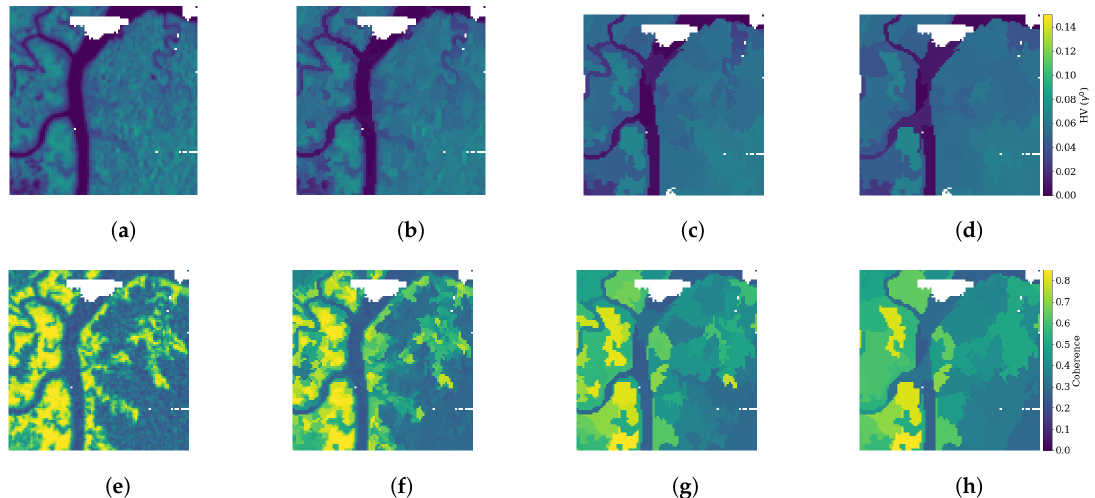
Figure 5. PALSAR-2 HV backscatter and HH coherence features (top and bottom row, respectively) derived from Felzenszwalb and Huttenlocher graph-based superpixels with increasing minimum size. From left to right, ( a ) original pixel data projected to biomass frame (50 m resolution), ( b ) mean backscatter with minimum segment size 5 pixels (1.25 ha), ( c ) mean backscatter with minimum segment size 25 pixels (6.25 ha), and ( d ) mean backscatter with minimum segment size 50 pixels (12.5 ha). Figures ( e – h ), are the analogous images derived using the mean HH coherence within superpixels. The maps are with respect to the reference AGB frame. The white areas in the imagery indicate where no data was collected by the